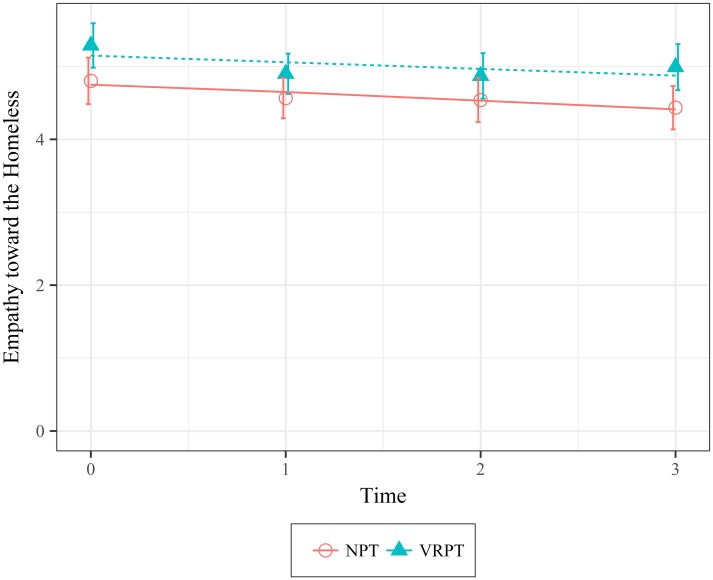
Mean values of empathy as a function of condition over time.Error bars represent 95% Confidence Intervals.